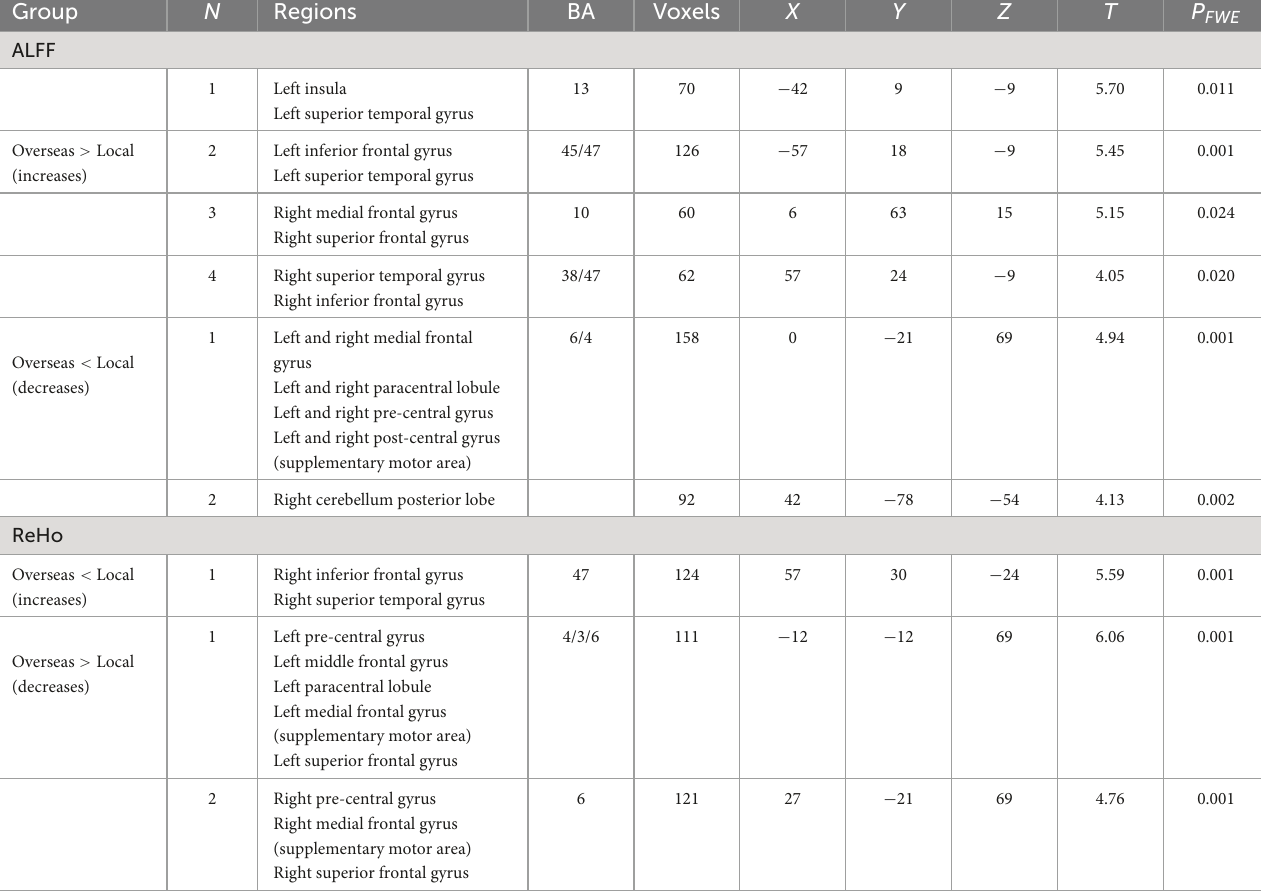
TABLE 2 Brain regions with significant alterations in ALFF and ReHo values between overseas students and local students.